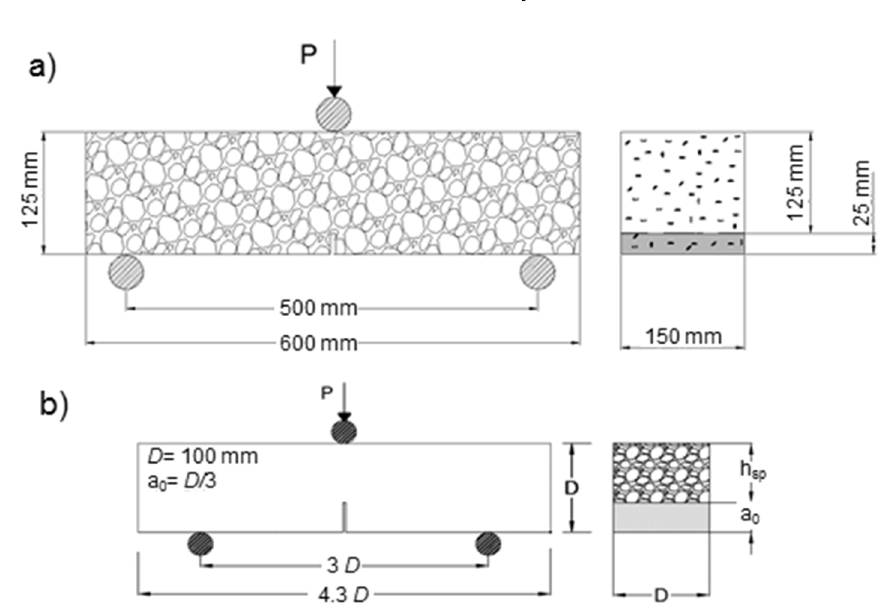
Figure 9. Configuration of the fracture tests: ( a ) EN 14651 and RILEM TC 162-TDF;